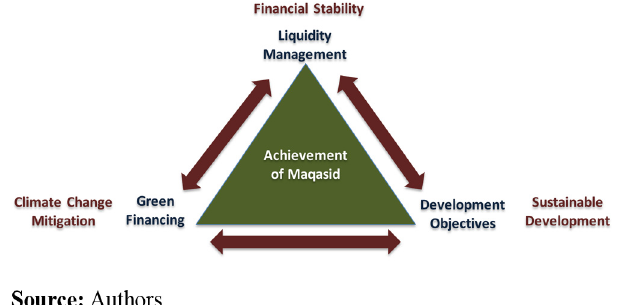
Figure 2. The UGIT triangle: a developmentalist approach to